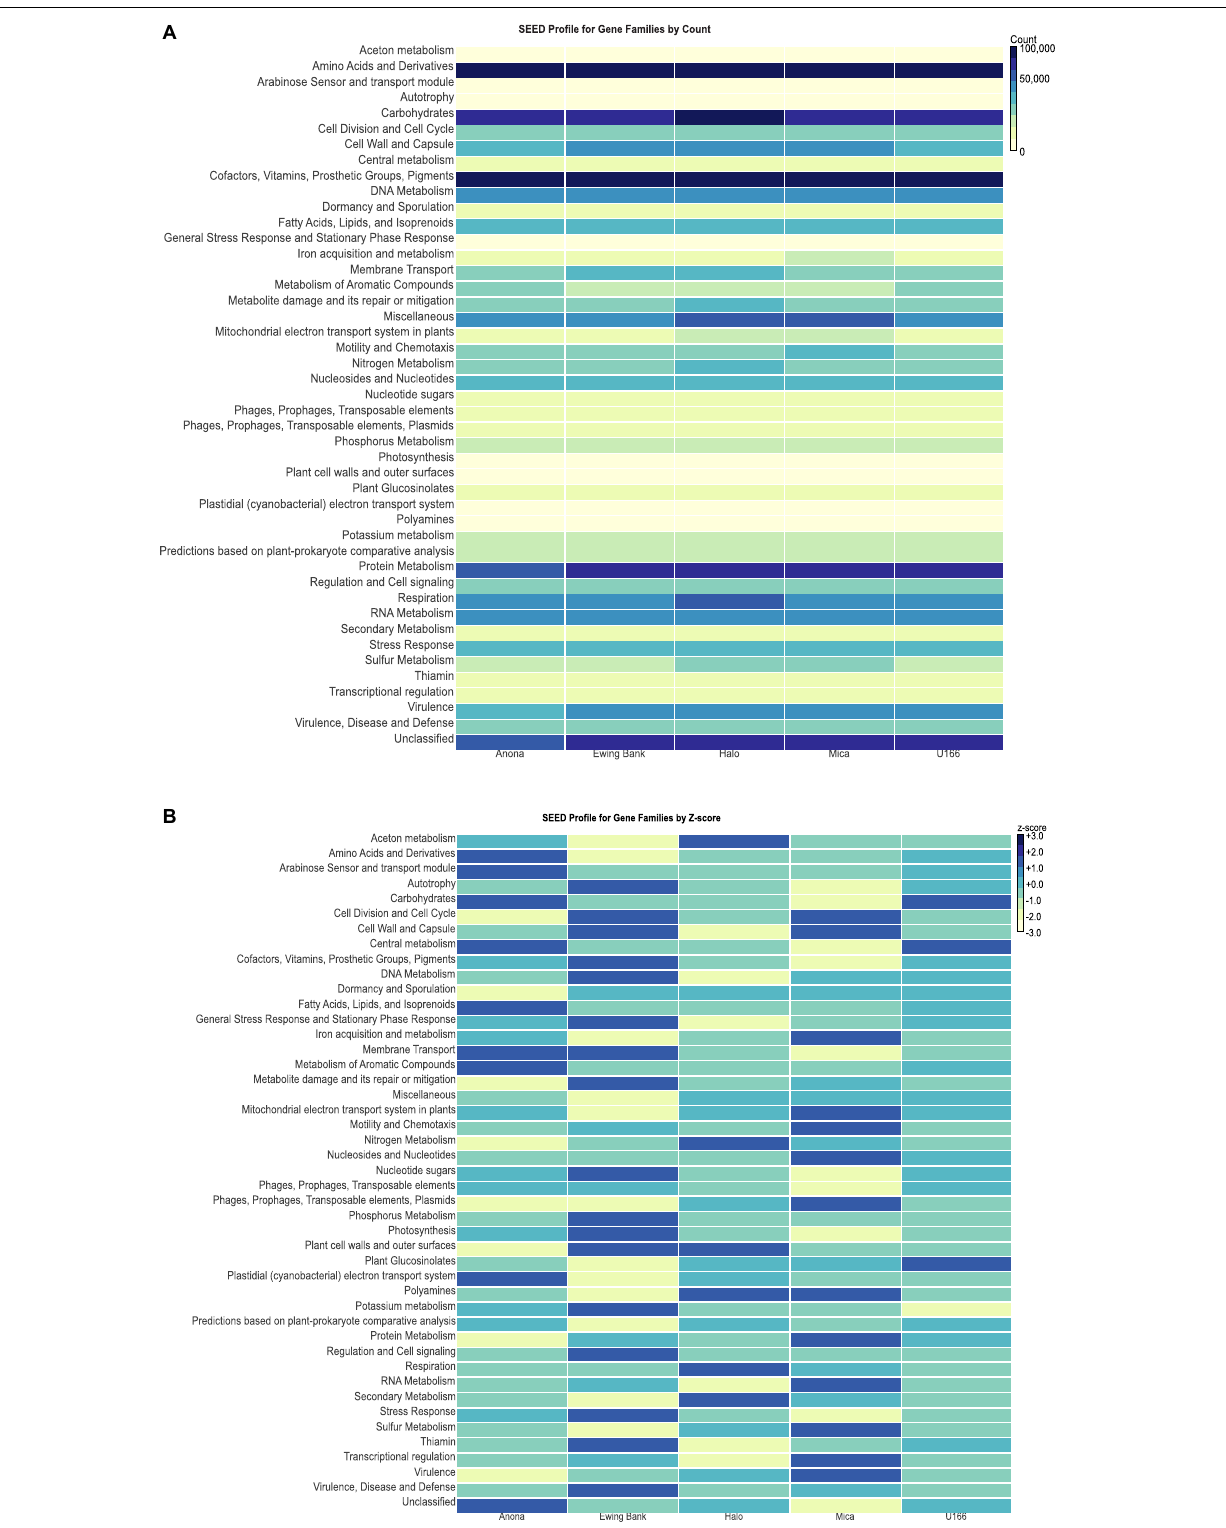
Frontiers in Marine Science |